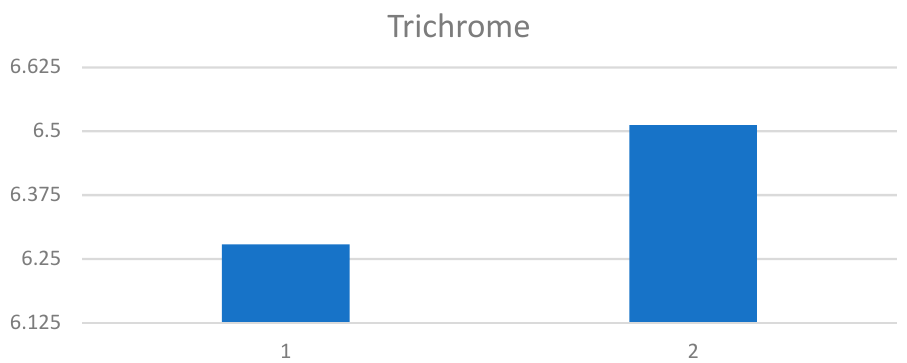
Figure 8. The comparison of specimens before and after the treatment revealed 26.6% rise in collagen concentration.